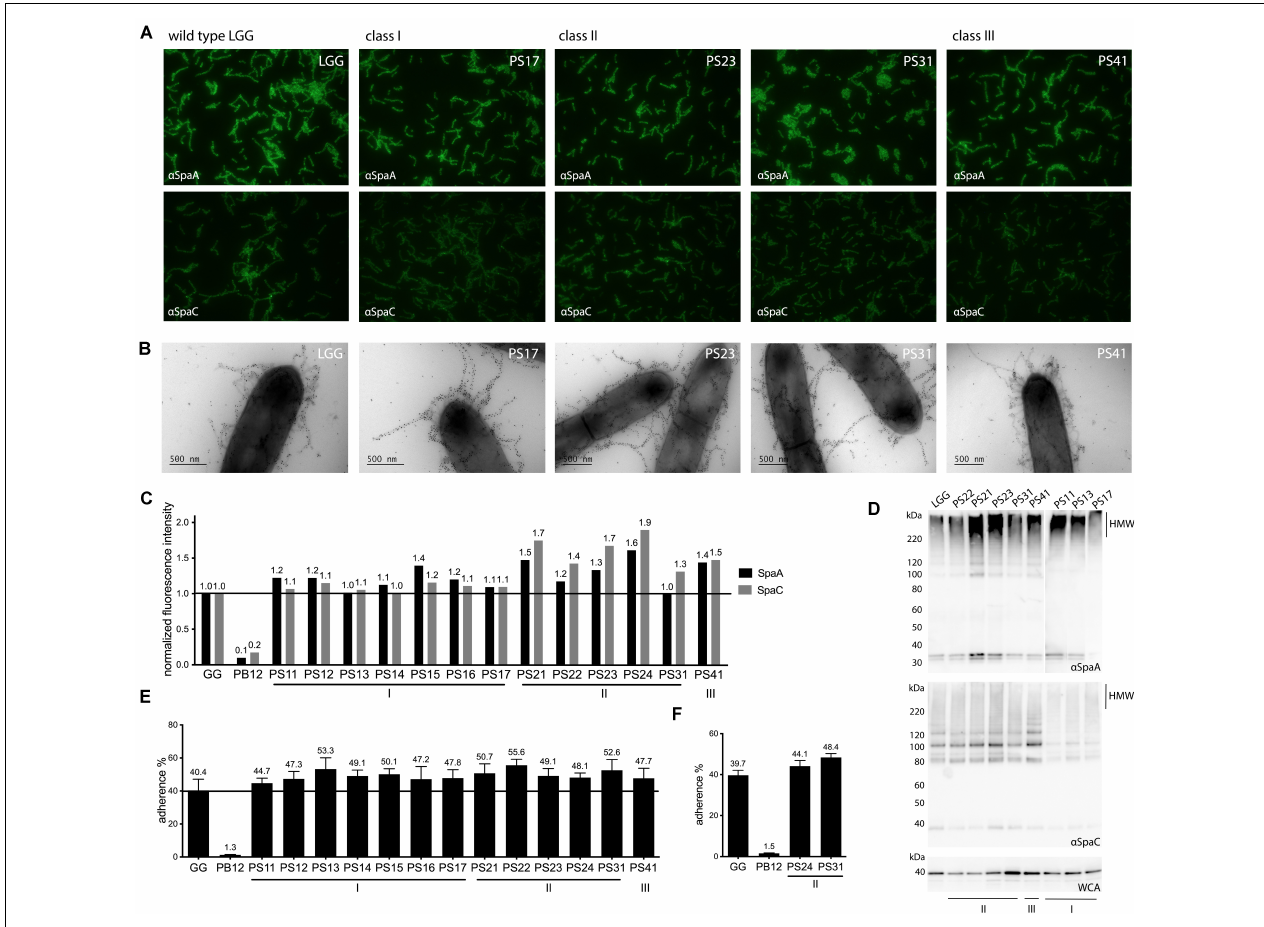
FIGURE 1 | Phenotypic assessment of piliation and mucus adhesion of highly mucus-adherent derivatives of L. rhamnosus GG. (A) Immunofluorescent labeling of SpaA and SpaC on cell surface of derivatives. Strains were labeled with either SpaA or SpaC antisera and detected with Alexa 488-labeled secondary antibody. Representative images are included for each strain. (B) Immunoelectron micrographs of strains double labeled with SpaC and SpaA antibodies. Both SpaC (5 nm gold particles) and SpaA (10 nm gold particles) are imaged on the pili of the different derivative strains (a representative figure is shown for each strain). (C) Quantitative immunofluorescent labeling results of SpaA and SpaC. Fluorescent signals of strains labeled with either SpaA and SpaC (detected by Alexa 488-labeled antibodies) were normalized to DAPI fluorescence. These values were further normalized to the fluorescence of the parental L. rhamnosus GG strain (indicated with a line to facilitate interpretation). A representative experiment is depicted. (D) Western blot analysis of cell wall associated proteome of each derivative. The pilus ladder (HMW for High Molecular Weight fraction) of the derivatives was visualized by probing cell wall extracts of each strain with SpaA and SpaC antibodies. Total amount of proteins is shown as a reference with a whole cell antibody (WCA) blot. (E) Mucus adhesion of the derivatives. The average result of 3 biological measurements (with each 3–6 technical repeats) is depicted for each derivative with wild-type L. rhamnosus GG as a positive control and the non-piliated derivative PB12 as a negative control. Standard error of mean (SEM) is shown. (F) Adhesion to human mucus. Adhesion of two derivatives, together with the positive and negative controls, to mucus isolated out of a human specimen, to validate porcine results. The average of three biological repeats is depicted with standard error of mean